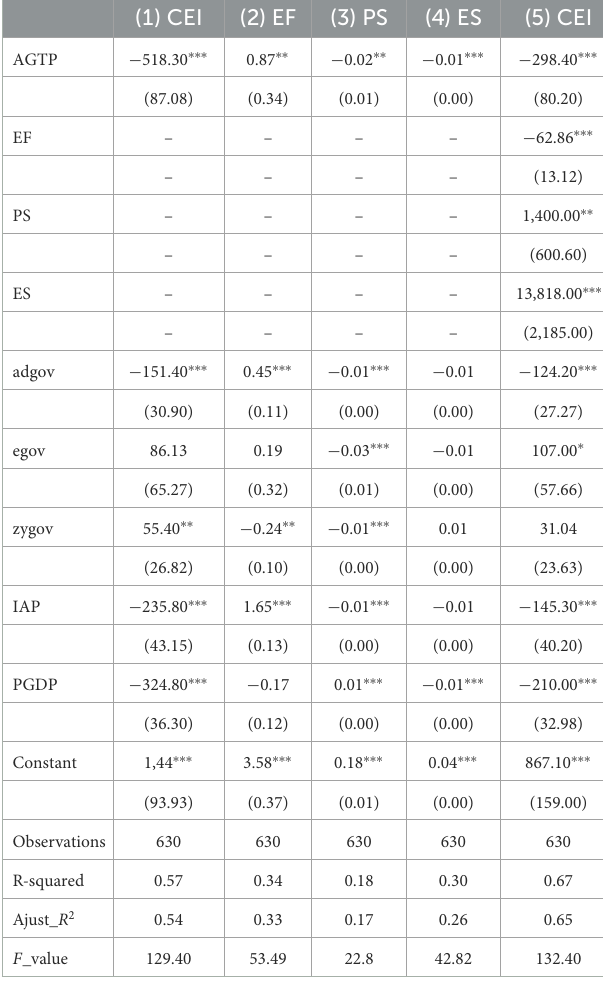
TABLE 4 Outcomes of full sample empirical